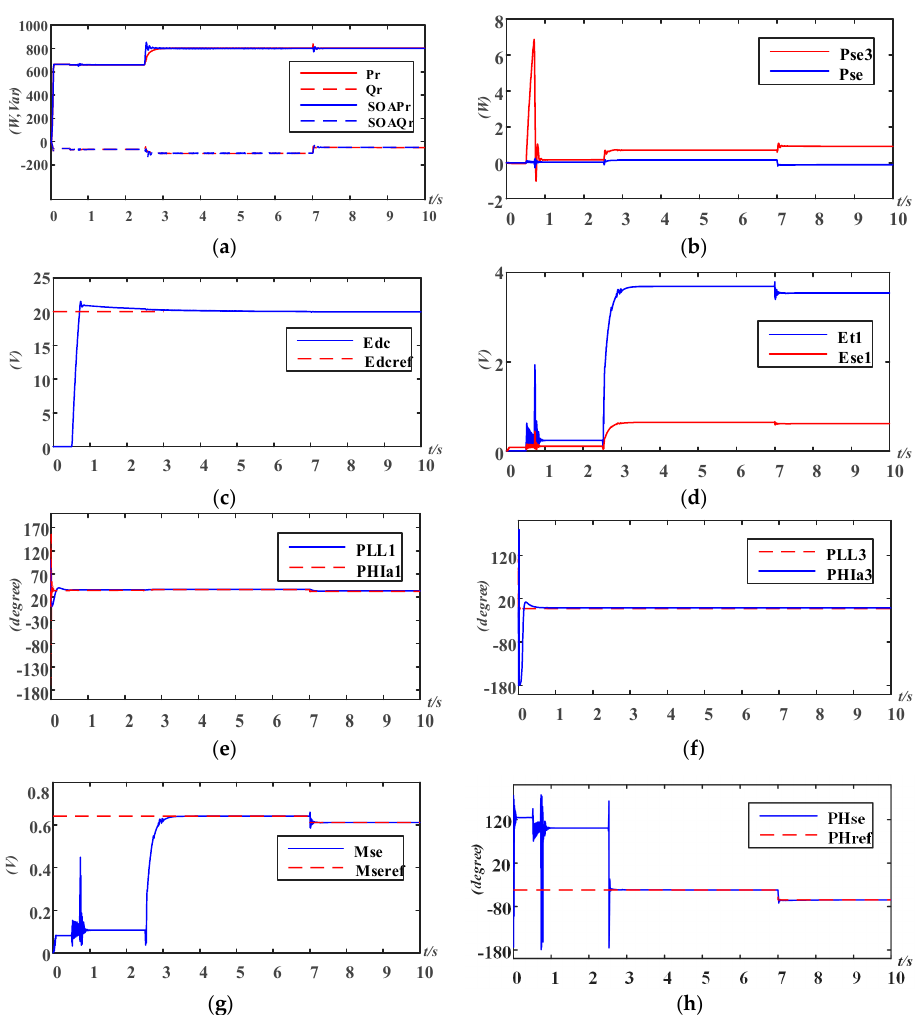
Figure 9. The simulation results of the DPFC control system. ( a ) Three-phase power flow at the receiving-end; ( b ) exchange of active power flow in the series unit; ( c ) DC capacitor voltage of each series unit; ( d ) magnitude of voltage of STT; ( e ) SPLL result of base-frequency line current; ( f ) SPLL result of third harmonic current; ( g ) the magnitude of compensated voltage; ( h ) the phase angle of compensated voltage.